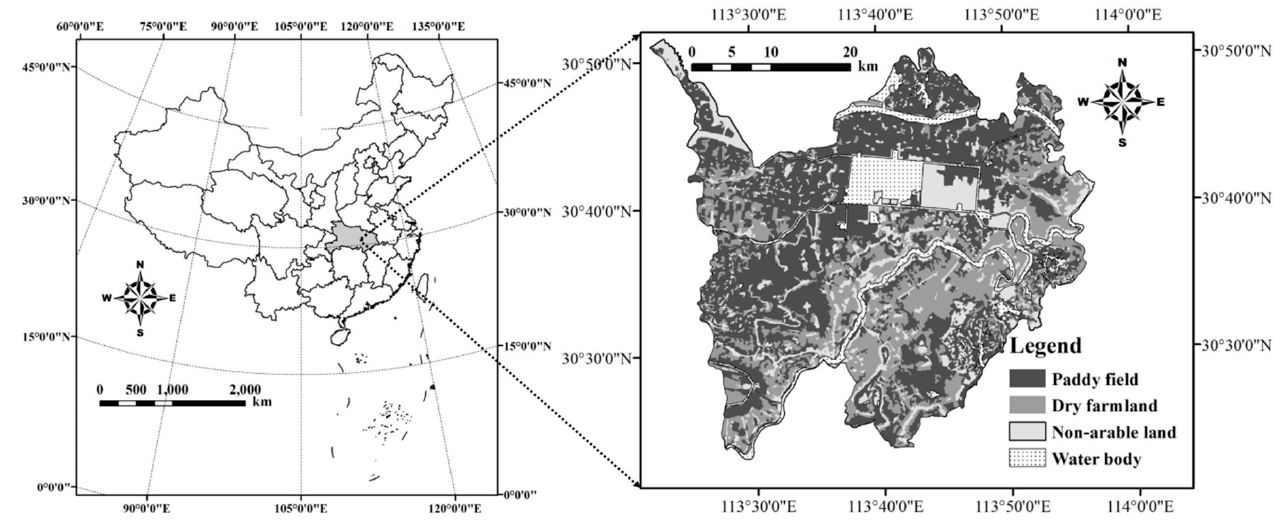
Figure 1. Location of the study area and the land-use type map.